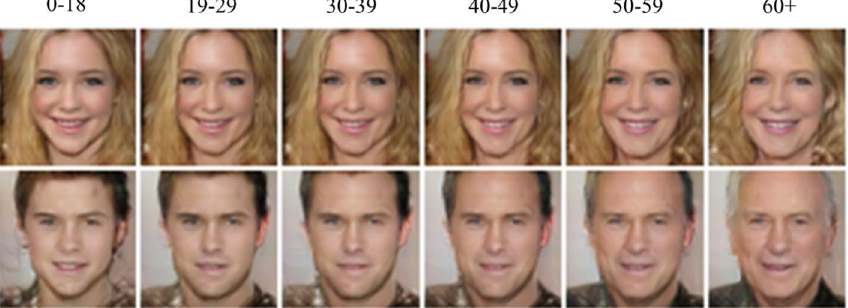
Fig. 21 An example of face age